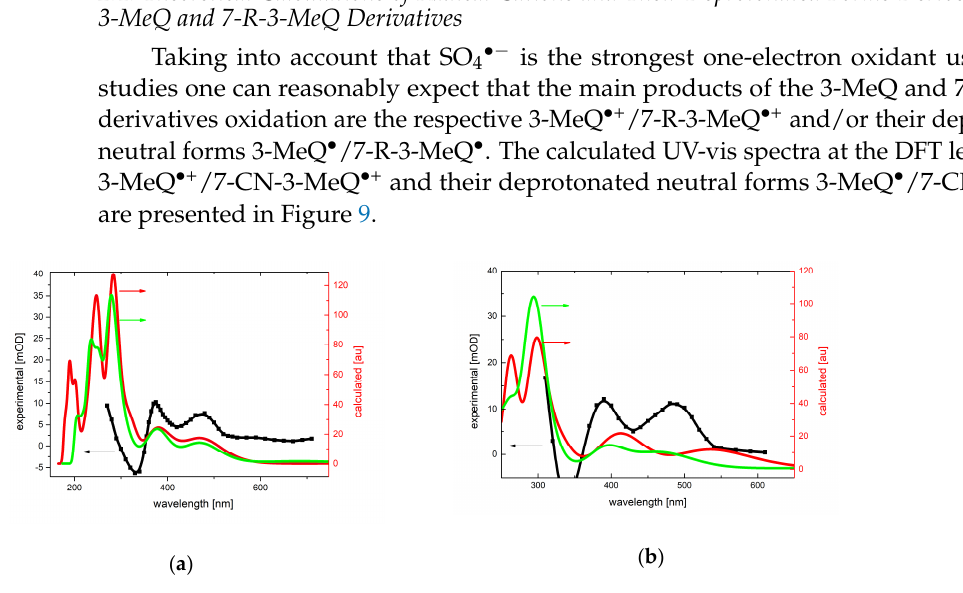
Figure 9. ( a ) Comparison of the transient absorption spectrum recorded in Ar-saturated aqueous solutions containing 0.1 mM 3-MeQ, 0.1 M K 2 S 2 O 8 and 0.5 M tert-BuOH at pH = 7 ( ■ , ▬) and the u-ωB97XD/aug-cc-pVTZ calculated UV-Vis spectra of the 3-MeQ •+ ( ▬ ) and 3-MeQ • ( ▬ ) species. Calculated spectra are shifted by 100 nm towards longer wavelengths; ( b ) Comparison of the transient absorption spectrum recorded in Ar-saturated aqueous solutions containing 0.1 mM 7-CN-3-MeQ, 0.1 M K 2 S 2 O 8 and 0.5 M tert-BuOH at pH = 7 ( ■ , ▬) and the u-ωB97XD/aug-cc-pVTZ calculated UV-Vis spectra of the 7-CN-3-MeQ • + ( (cid:4) ) and 7-CN-3-MeQ • ( (cid:4) ) species. Calculated spectra are shifted by 80 nm towards longer